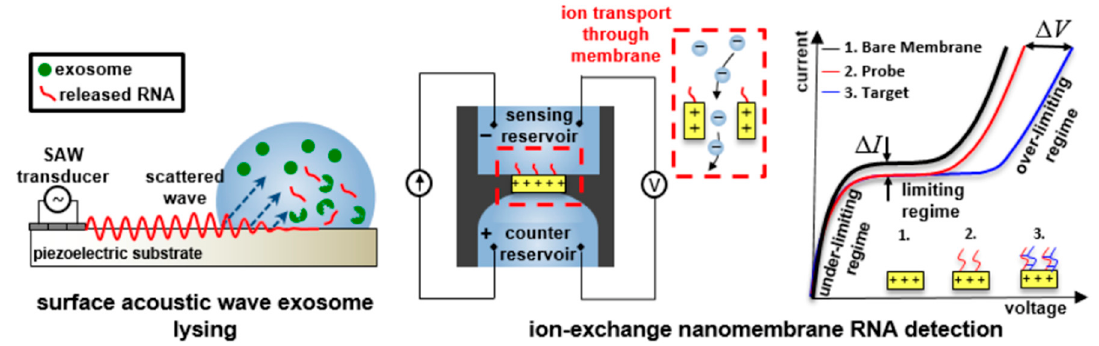
Figure 4. On-chip surface acoustic wave lysis and ion-exchange nanomembrane detection of exosomal RNA for the study and diagnosis of pancreatic cancer, developed by Taller et al. [139]. Reproduced with permission from the Royal Society of Chemistry (RSC).